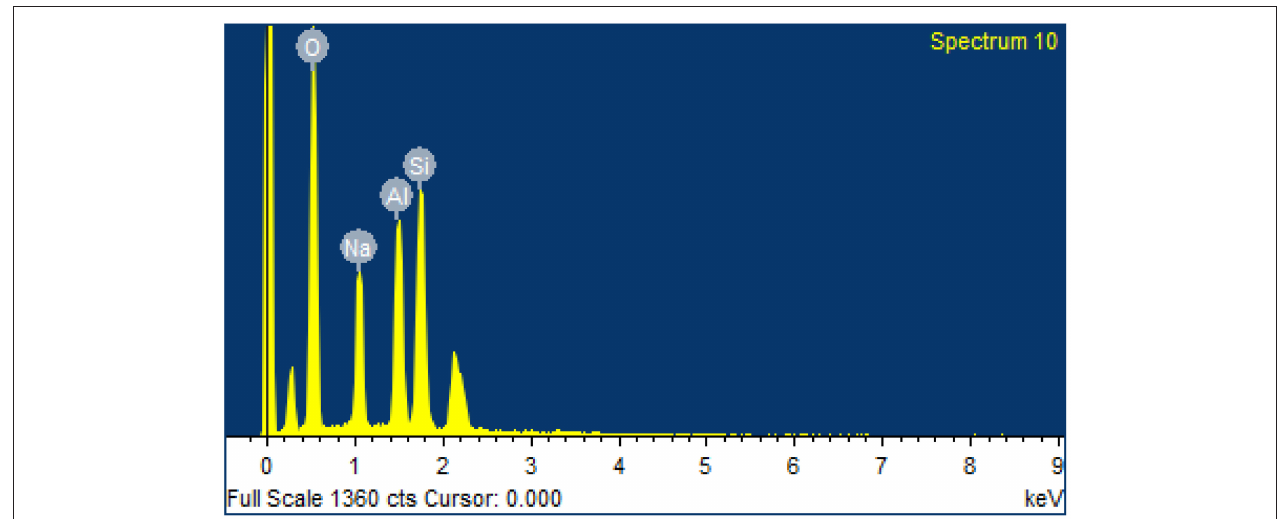
FIGURE 5 | EDS analysis of zeolite X samples.